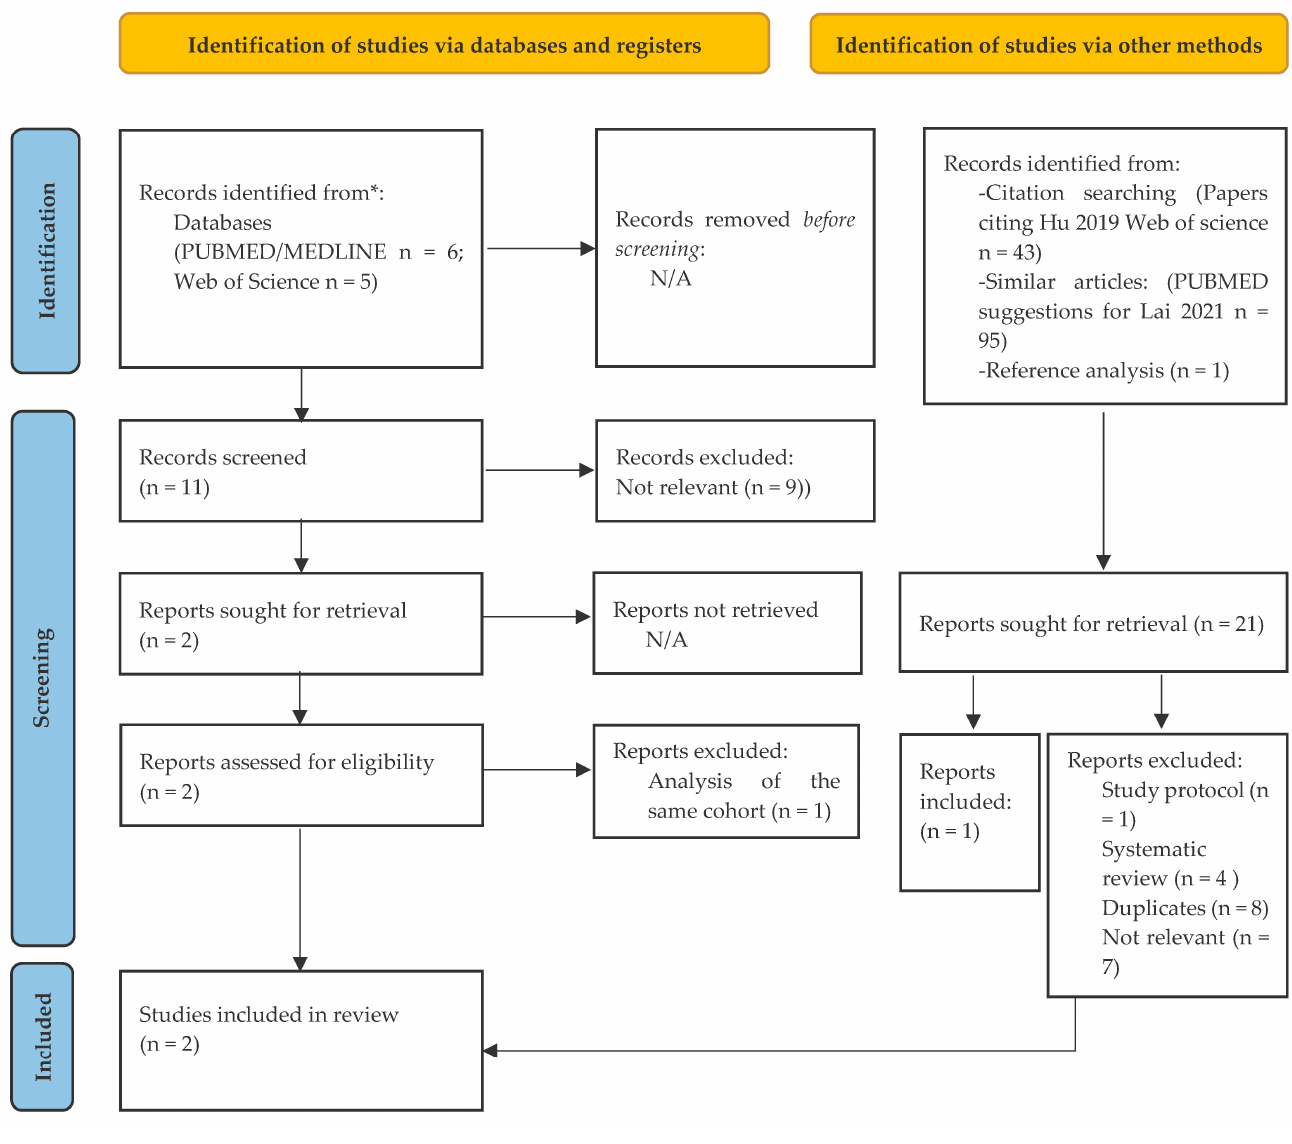
Figure 1. Preferred Reporting Items for Systematic Reviews and Meta-analysis (PRISMA) [26] flowchart. Hu et al., 2019 [27], Lai et al., 2021 [28].